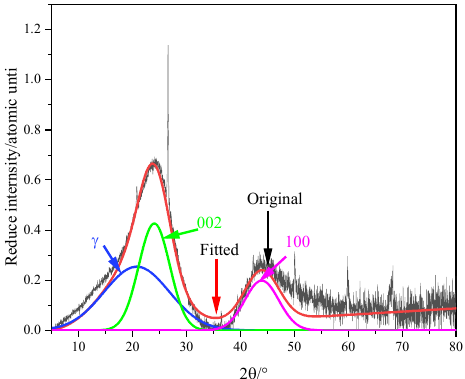
Figure 5. The curve fitting of the XRD spectra of coal char A600. where d 002 represents the interplanar spacing of two aromatic layers of the microcrystalline carbon, Å; λ is the X ‐ ray wavelength ( λ = 0.1541 nm); L c is the stacking height of the crys ‐ tallites, Å; L a is the lateral size of the crystallite plane, Å; θ 002 and θ 100 are the diffraction angles of the (002) and (100) peaks, respectively, °; β (002) and β (100) are the full width at half maximum of the (002) and (100) peaks, respectively, °; and N is the average layer number estimated from the equation N = L c / d 002 [12,29].